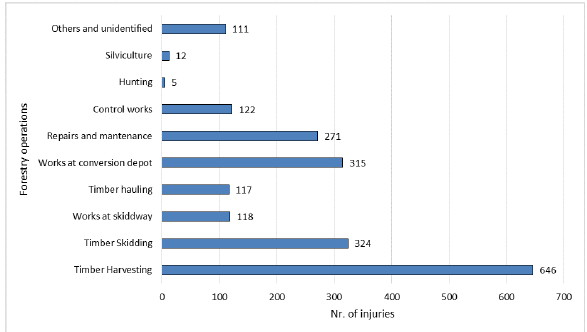
Figure 1: Workplace injuries in State forestry enterprise in the years 2000-2017